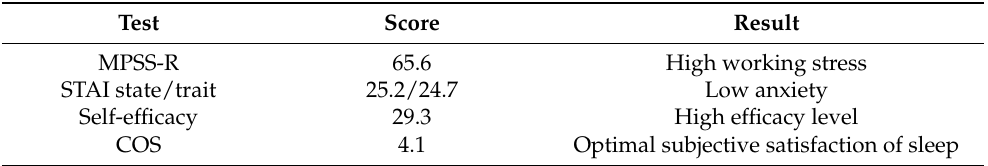
Table 3. Summary of scores (expressed as means) obtained from the different tests passed to ED professionals in previous studies by our group and the corresponding interpretation. For additional details regarding different dimensions of these scores, see [31,32].